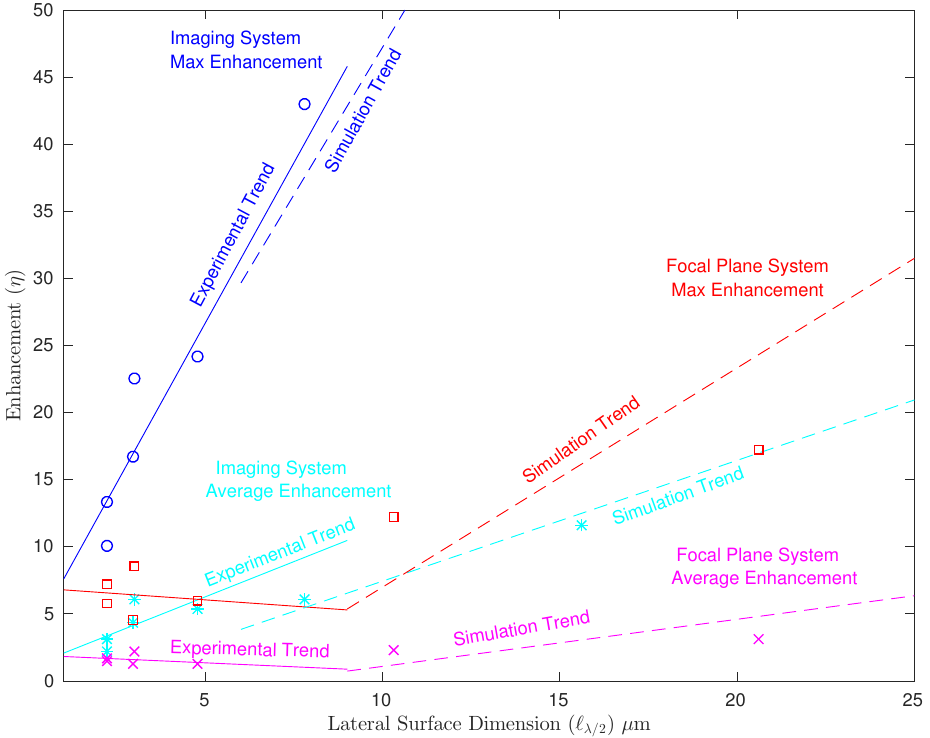
Figure 7. Enhancement ( η ) vs. Lateral Surface Dimension ( (cid:96) λ /2 ). Simulations are conducted with a random shift in the sample prior to each intensity measurement. The solid lines are experimental data trends, and dashed lines represent simulation data trends. The simulated focal-plane system is subject to a random 20.6- µ m shift; maximum enhancement is shown in red, while average enhancement is shown in magenta. The simulated imaging system is subject to a random 23.4- µ m shift; maximum enhancement is shown in blue, while average enhancement is shown in